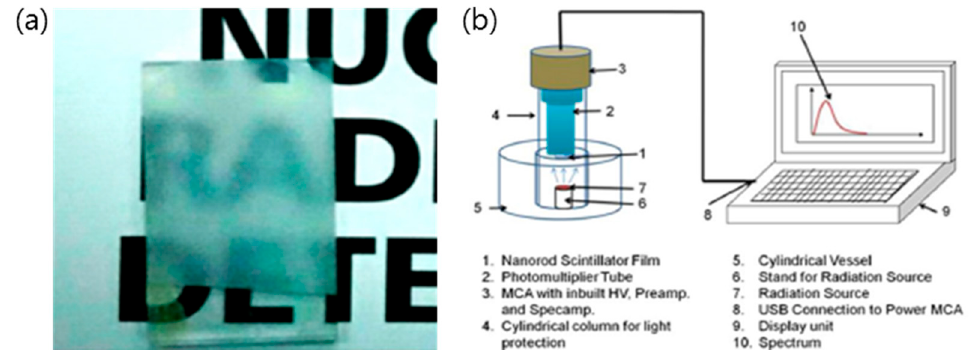
Figure 33. ( a ) Semitransparent nature of grown nanorods (ZnO:Ga/glass) and ( b ) pulse height spectra for different α sources [101].